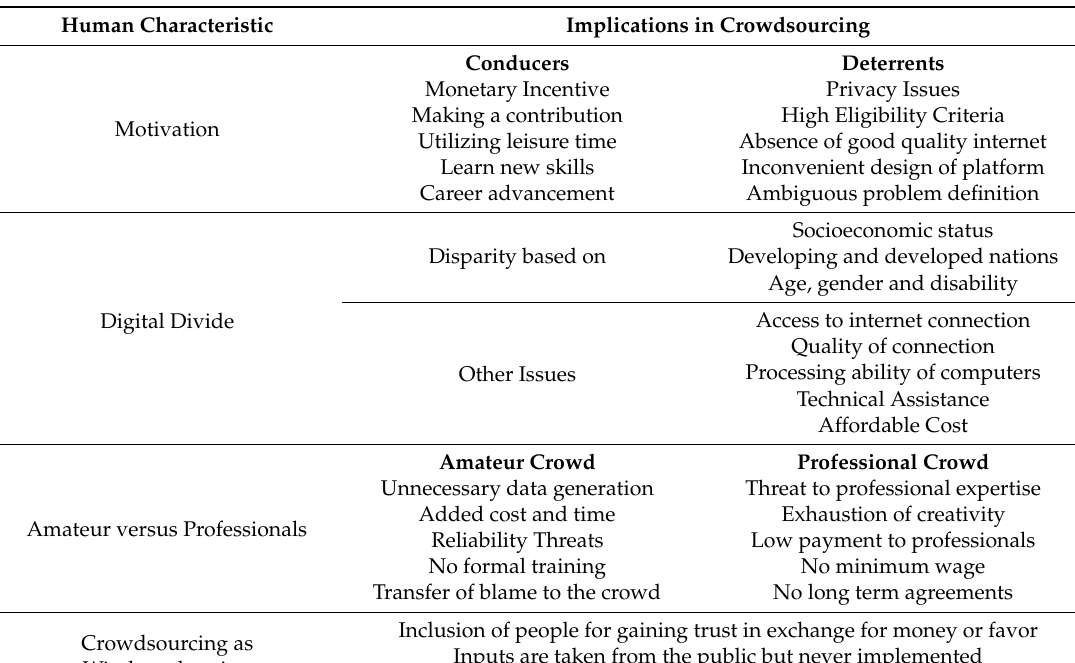
Table 2. Human characteristics affecting the feasibility of